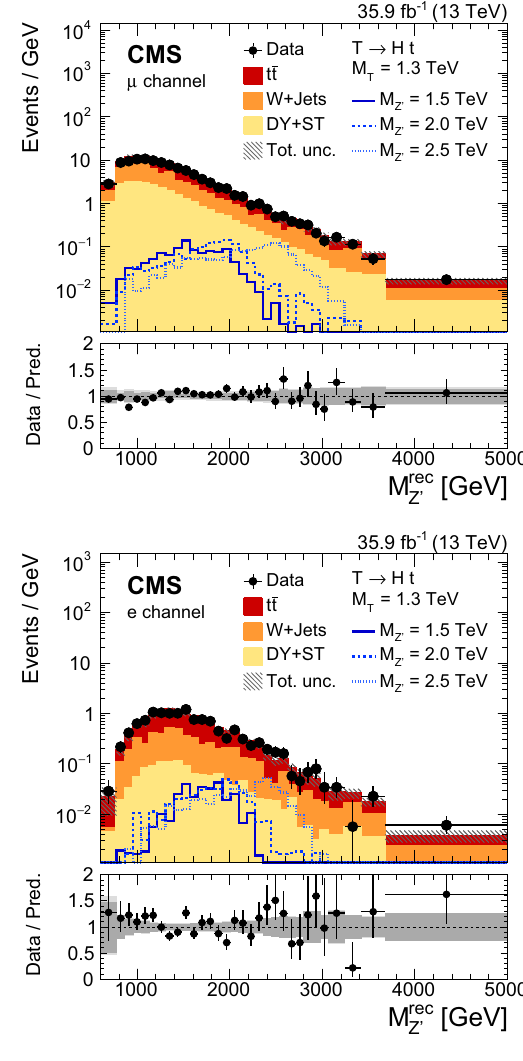
cross section σ( Z (cid:3) → tT ) of 1pb. The lower panel shows the ratio of data to predicted background. Here the darker grey band indicates the statistical uncertainty, whilst the lighter grey band shows the combined statistical and systematic